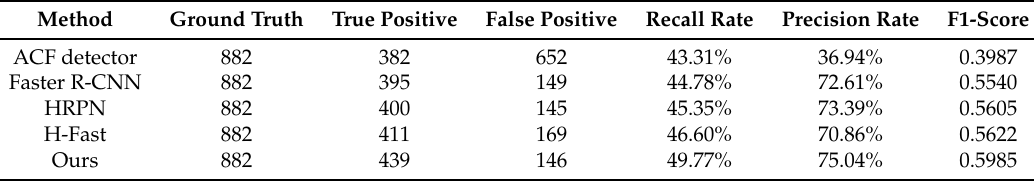
Table 5. Results of different methods for the collected vehicle